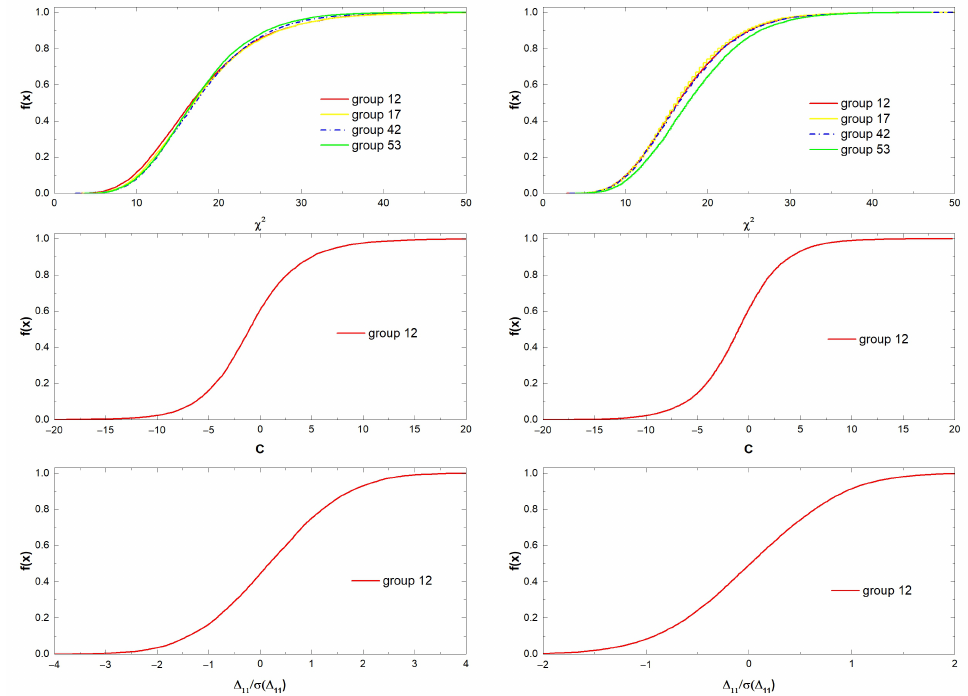
Figure 2. The Cumulative Distribution Function (CDF) of the angle δ D (left panel) and η (right panel) for analyzed statistics. From up to down are presented statistics: χ 2 , C and